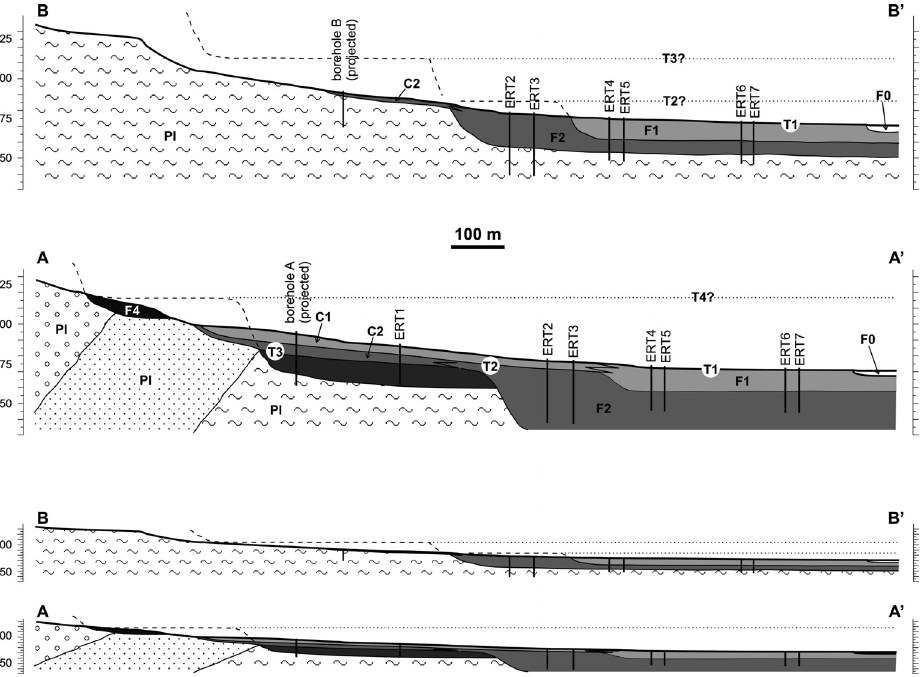
Fig. 8. Geological profiles parallel to the Scorciabuoi Fault and running immediately SW (A-A l ) and NE (B- B l ) of the fault trace across the Sauro Valley. Profiles location is in fig. 3a,b, while symbols are as in fig. 5. The two upper profiles have a vertical exaggeration of 3:1, while the below ones are the same shown with no verti- cal